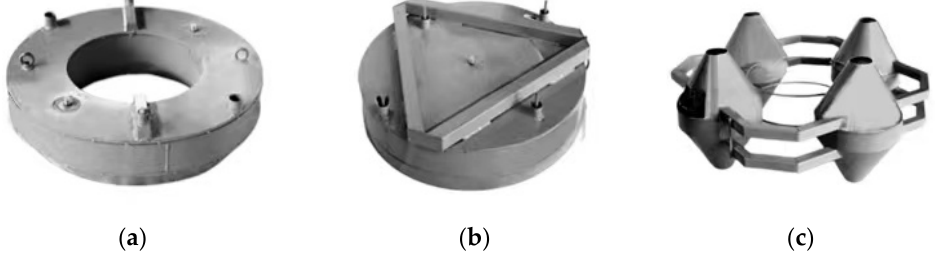
Figure 4. Supercell products: ( a ) donut-shaped supercell, ( b ) solid supercell and ( c ) multiple super- cells.